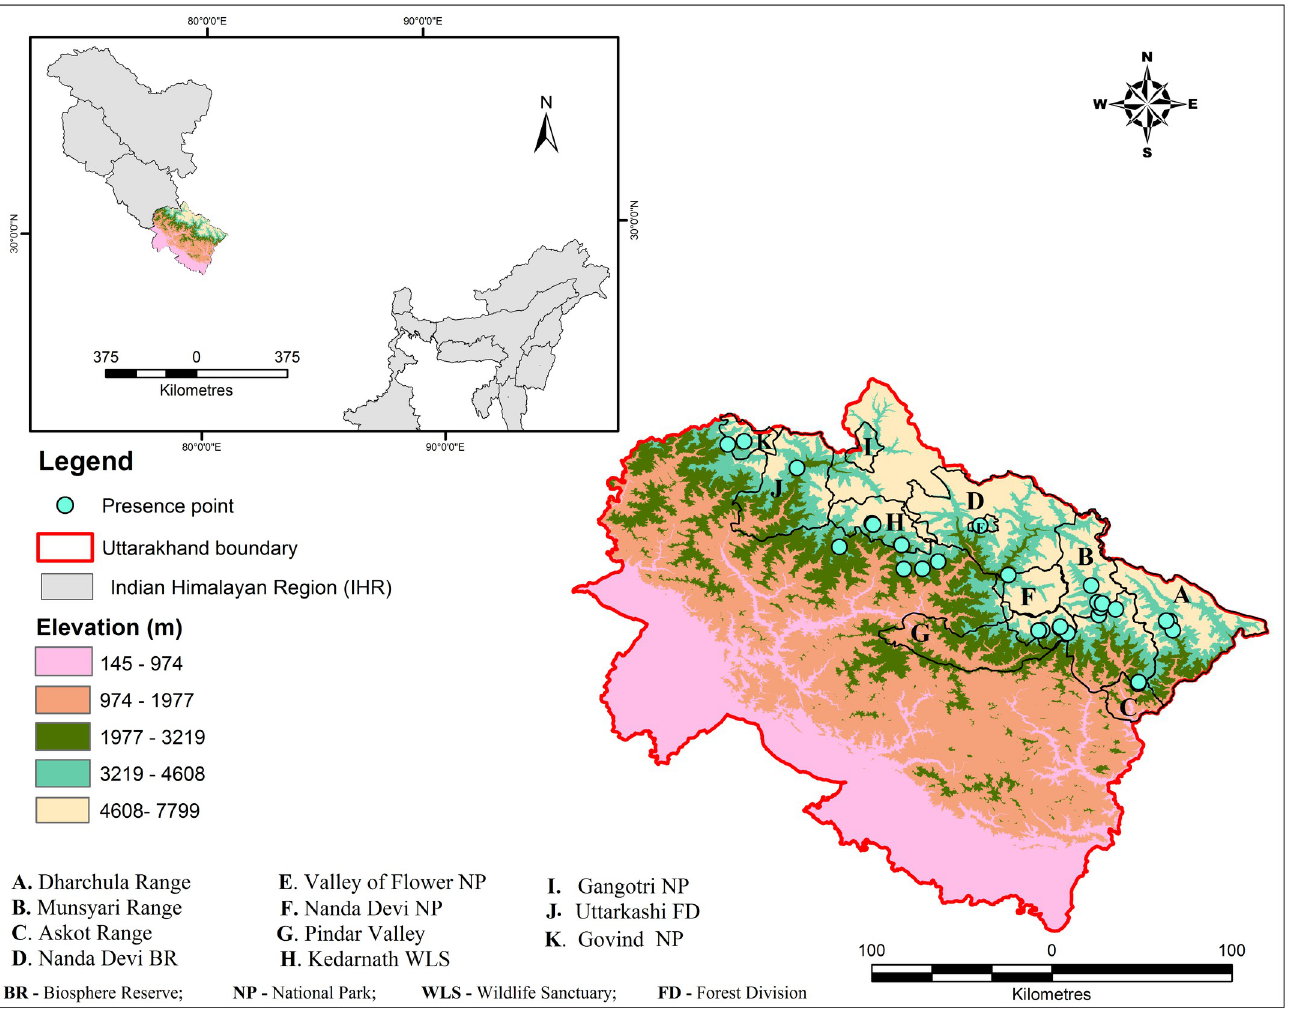
Fig 2. Field collected D . hatagirea (blue dots) points mounted on the elevation map of Uttarakhand state. Maps in Fig 1 are generated with ArcGIS version 10.3 (ESRI, CA, USA).